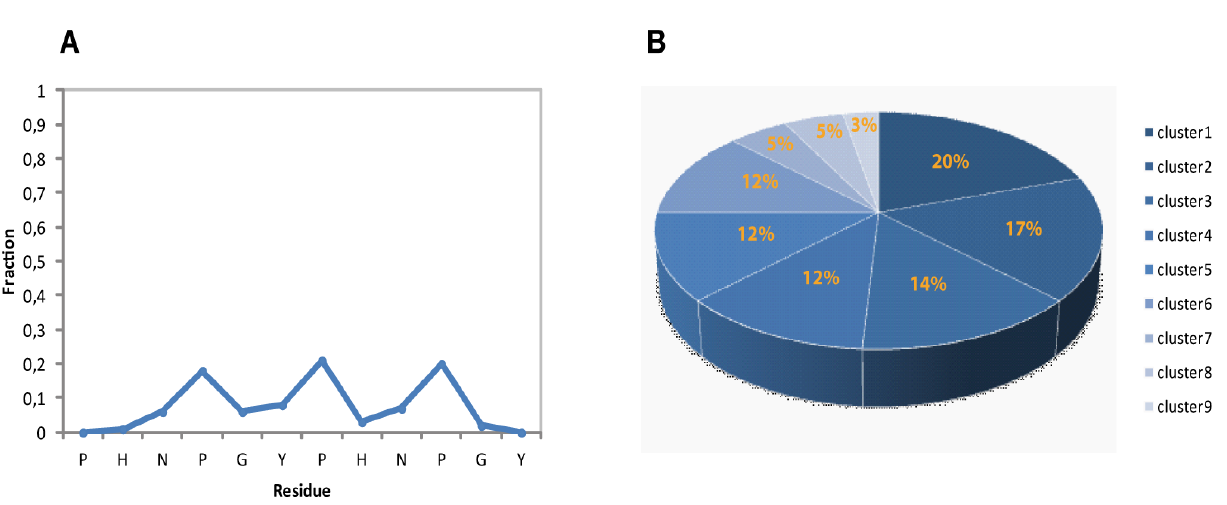
Figure 4. ( A ) Secondary structural propensity of 2-HexaPY Ensemble: fraction of conformers in the PPII region of the Ramachandran plot as a function of the residue number. ( B ) Cluster analysis of the final